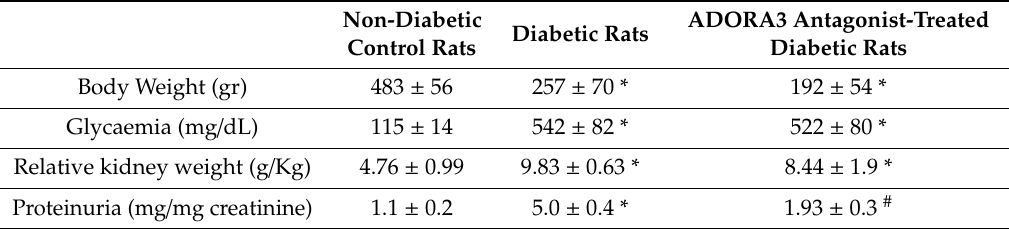
Table 1. Physiological parameters of experimental groups.